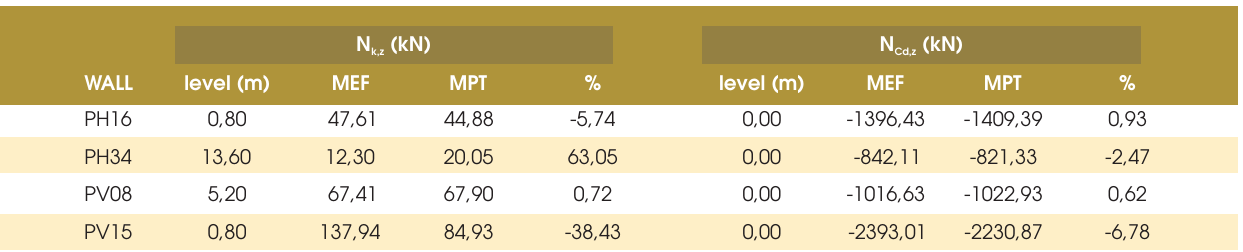
Table 6 – Comparison of the maximum N , and N , on the walls PH16, PH34, PV08 and PV15 k,z